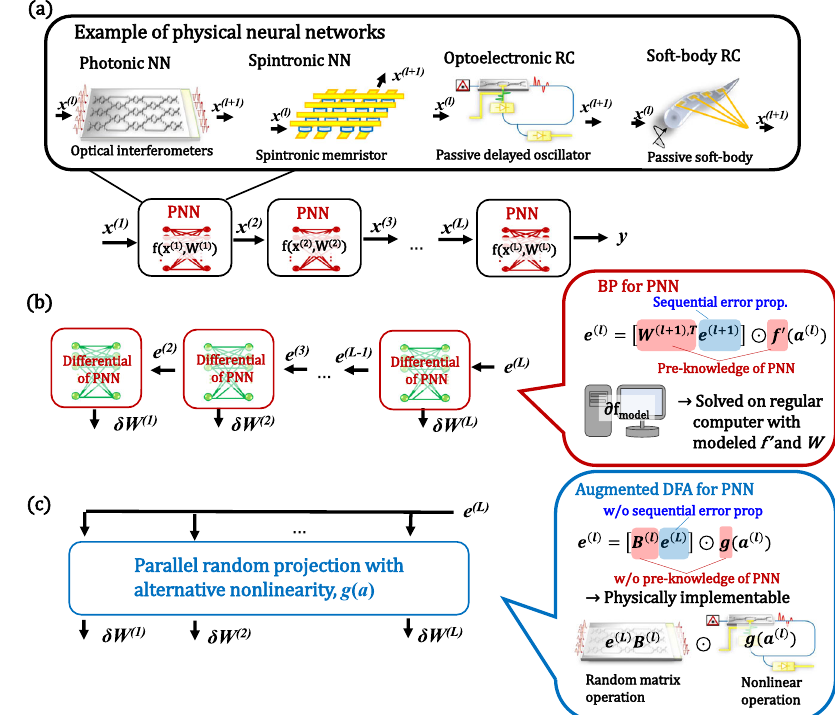
Fig.1|ConceptofPNNanditstrainingbyBPandaugmentedDFA.a Schematics of physical neural networks (PNNs). Training sequence of PNN with b BP, and c augmentedbiologicallyplausibletrainingcalleddirectfeedbackalignment(DFA).